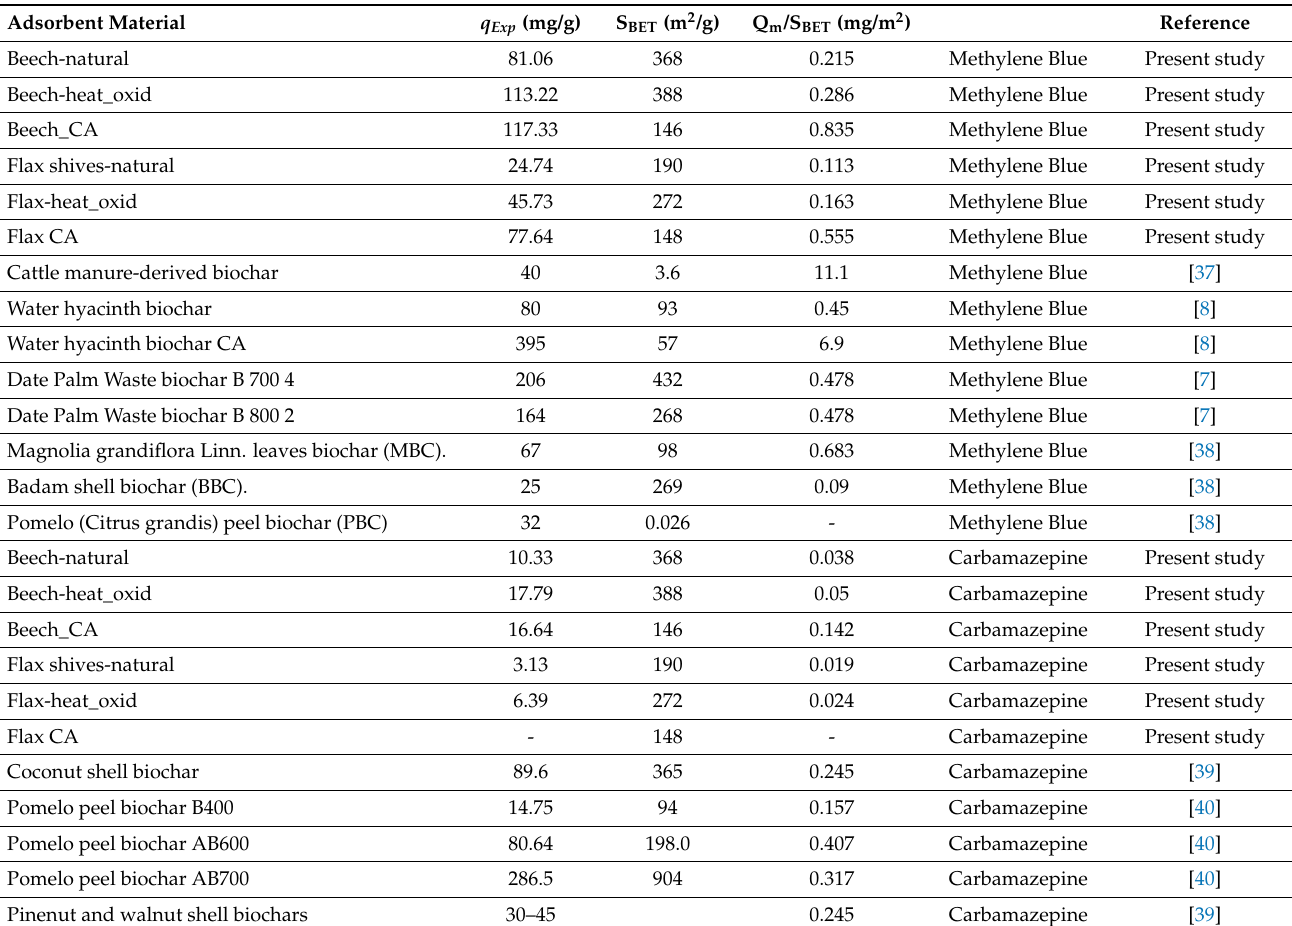
Table 3. Specific surface area results for the studied biochars and maximum adsorption capacity normalized per surface